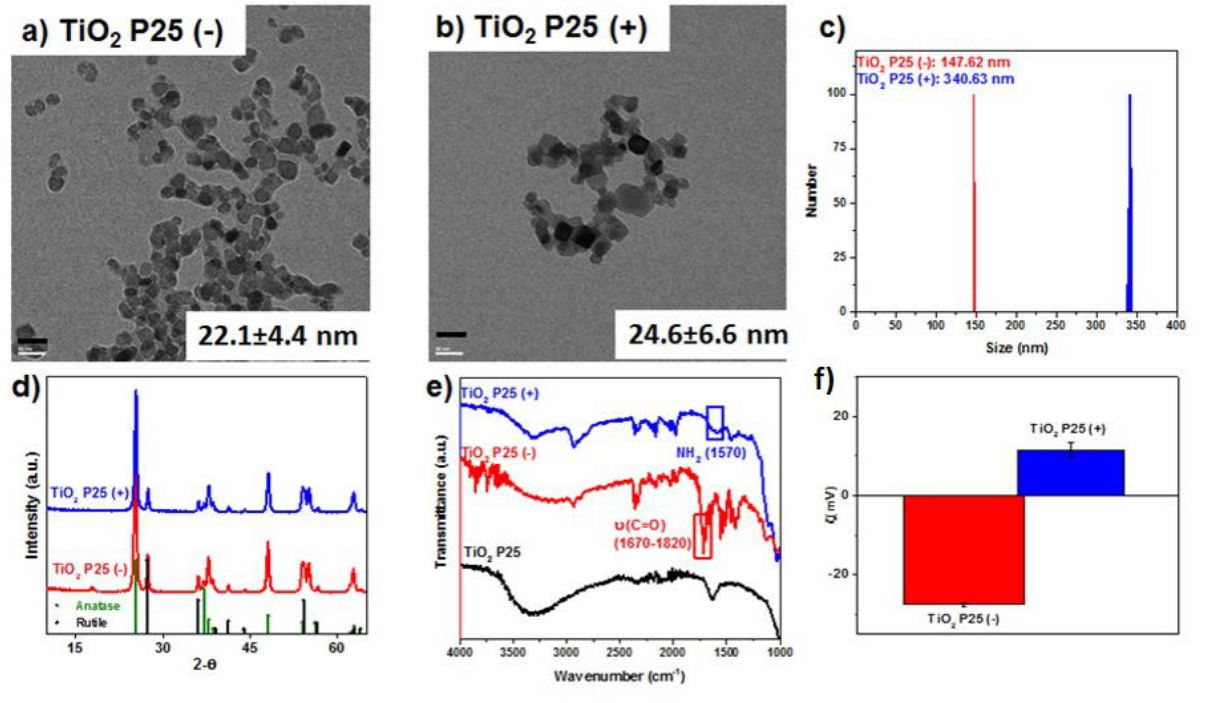
Figure 2. ( a , b ) Transmission electron micrographs of Degussa P25 (TiO 2 ) functionalized with COOH (−) and NH 2 (+) groups, respectively. Scale bars are 50 nm; ( c ) dynamic light scattering measurements; ( d ) powder X-ray diffraction patterns; ( e ) FTIR spectra; and ( f ) zeta potential measurements of TiO 2 P25 (−) and TiO 2 P25 (+) samples,